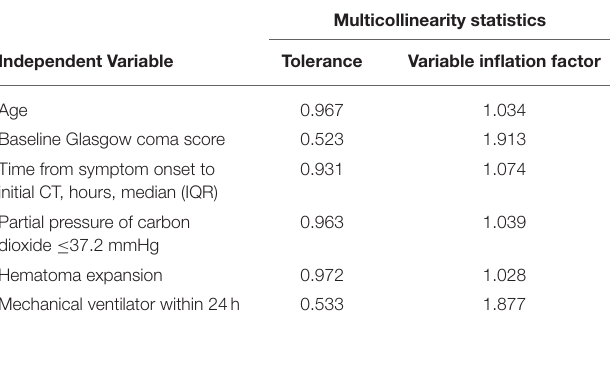
TABLE 2 | Multicollinearity test for the factors of a multivariate model.